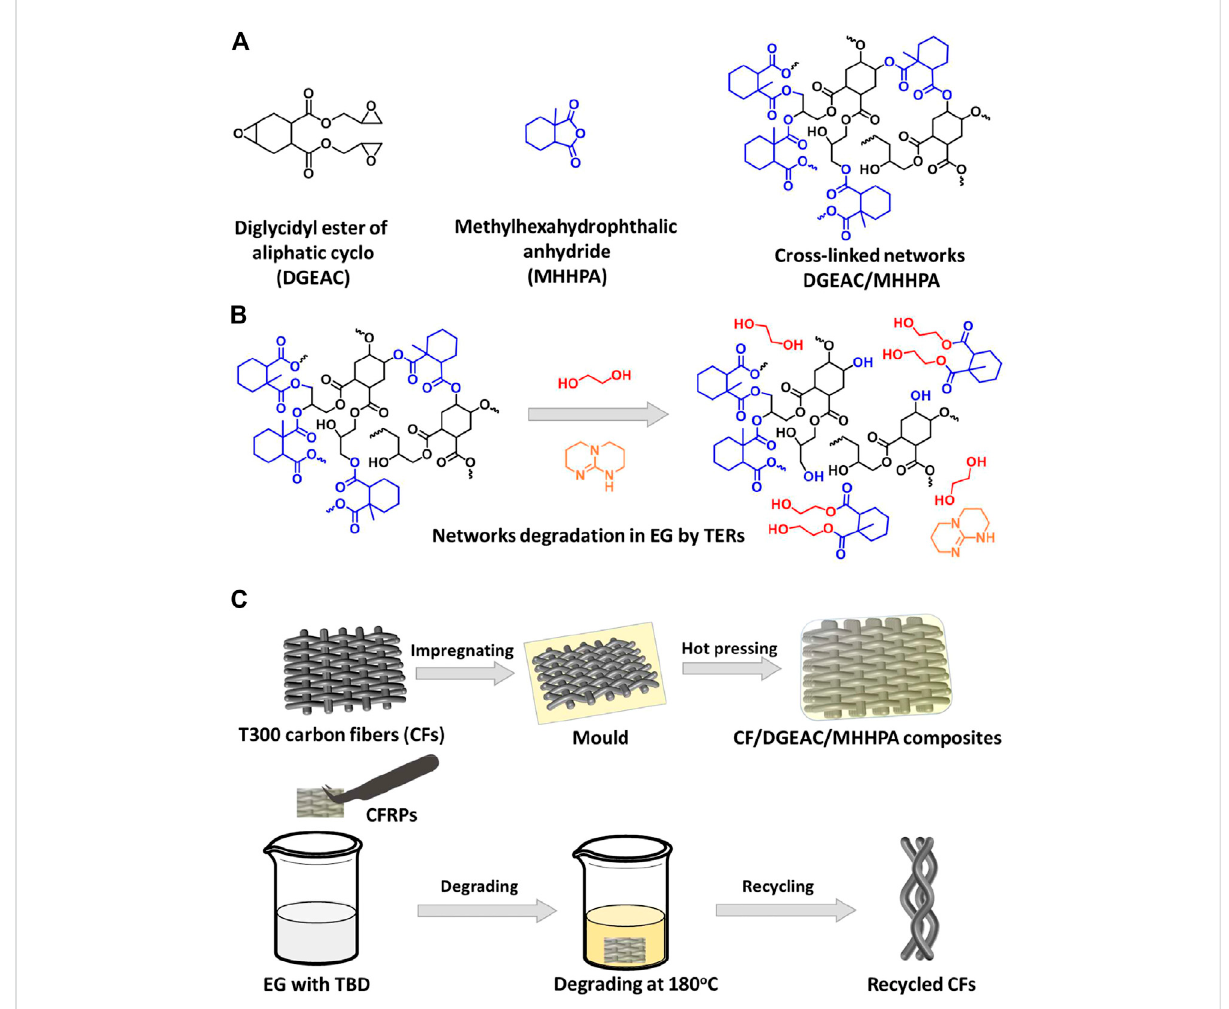
FIGURE 1 (A) Chemical structures of DGEAC, MHHPA, and DGEAC/MHHPA networks. (B) Proposed mechanism of transesteri fi cation reactions (TERs)- induced degradation of DGEAC/MHHPA networks in ethylene glycol (EG) in the presence of catalyst TBD. (C) Scheme of the preparation and recycling process of CF/DGEAC/MHHPA